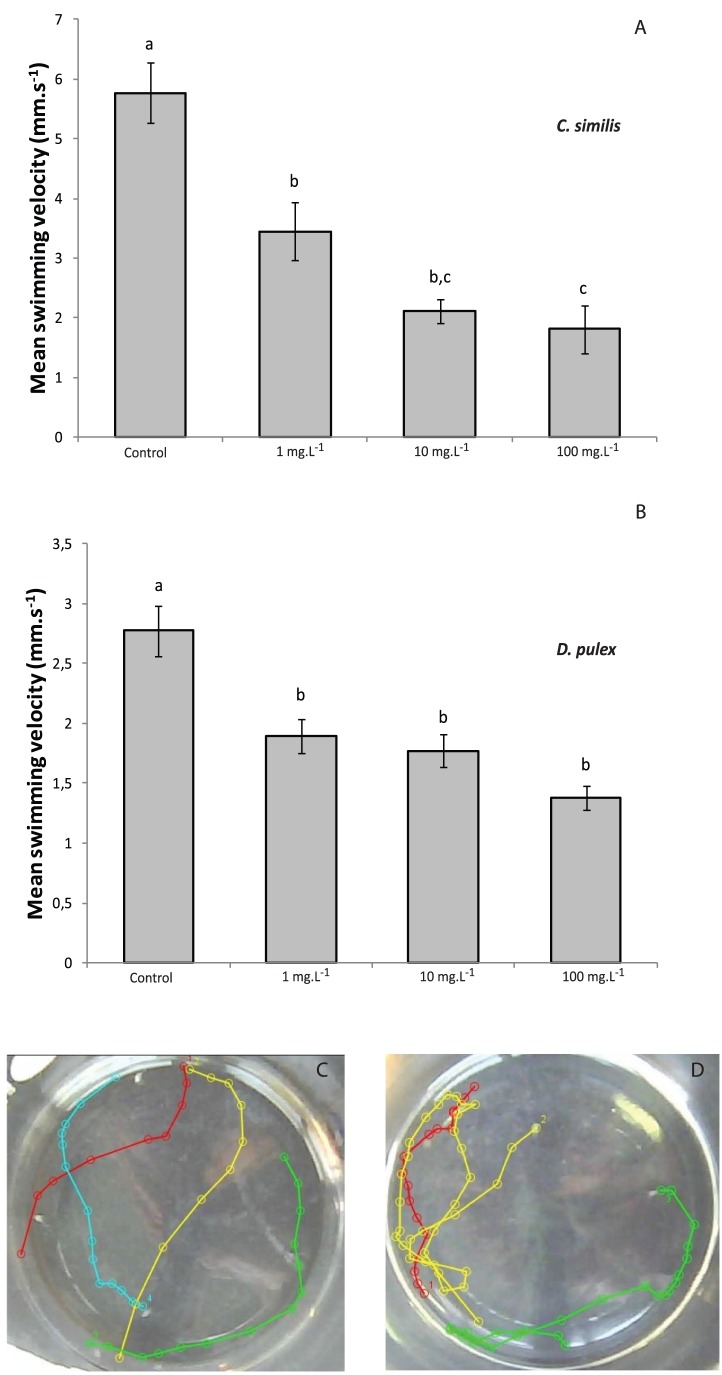
Mean swimming velocity in D. similis (A) and D. pulex (B) exposed to CeO2 NPs for 48 h.Values are means ± SEM. Letters show significant differences established by one-way ANOVA and Tukey post-hoc (p<0.05). D. similis swimming tracks in control (C) and after a 48-h exposure to 10 mg.L−1 of CeO2 NPs (D).